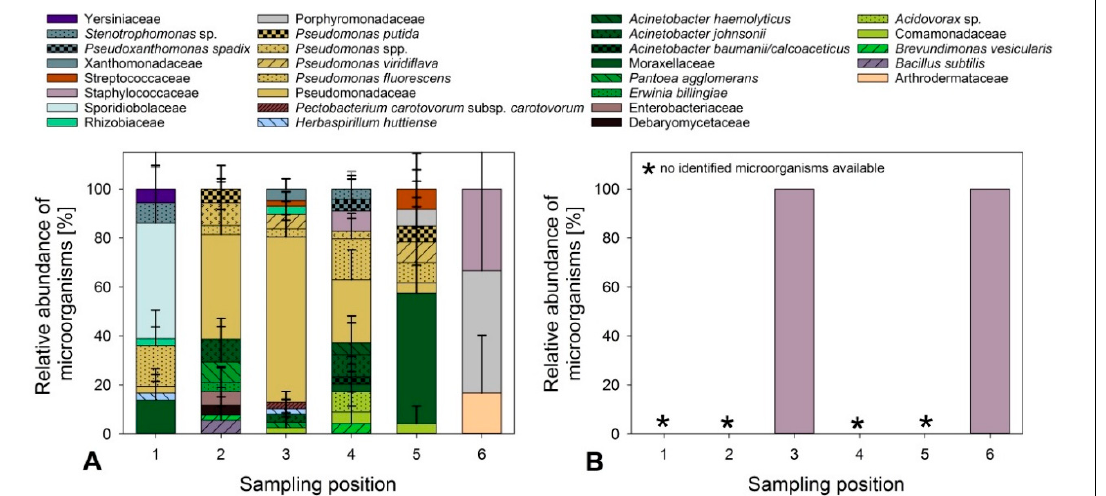
Figure 2. Culturable microbial community structure of endive lettuce (identified colonies only) along the washing process chain. The washing was conducted with the addition of plasma-treated water (PTW) in the pre-bath (trial D) and the samples were analyzed after washing ( A ) and after storage for seven days at 2 °C ( B ). Sampling positions: (1) endive raw material; (2) endive after pre-bath; (3) endive after pre-rinsing; (4) endive after first wash; (5) endive after second wash; (6) endive after final rinsing.